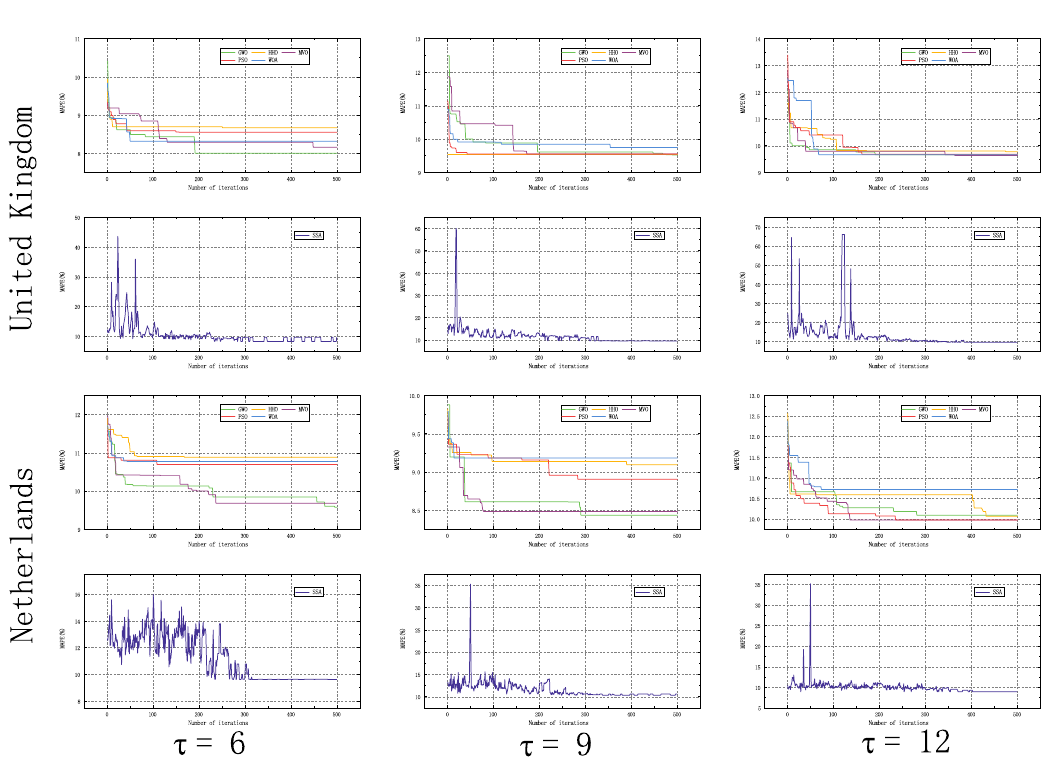
Figure 8. Convergence curves by GWO, HHO, MVO, PSO, WOA and SSA for LightGBM in different cases.